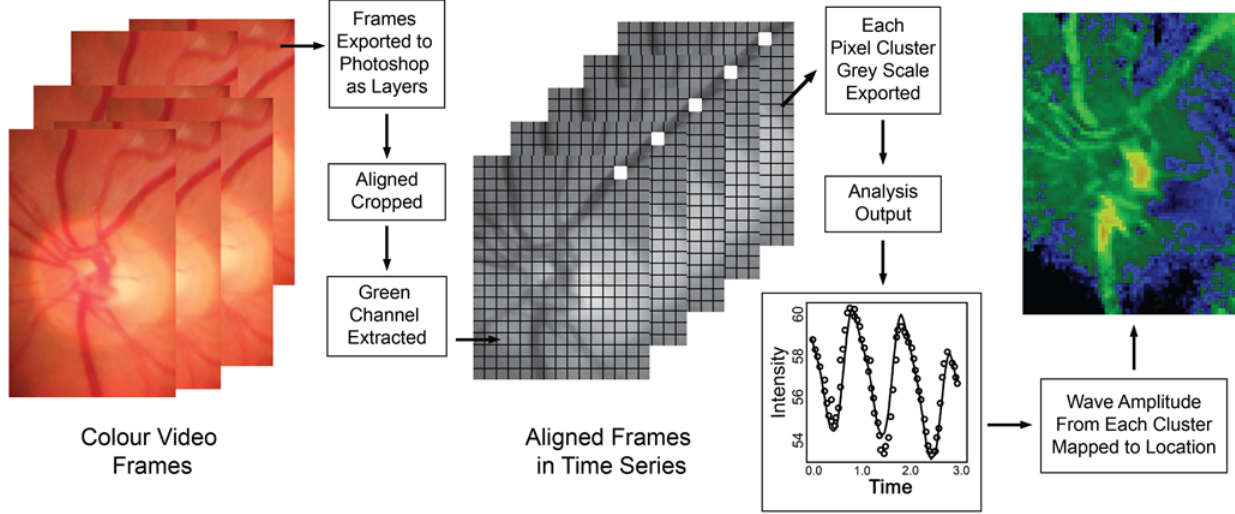
Figure 1. Schematic diagram of the technical sequence for objectively analysing the video frames, calculating pulsation amplitudes and generating heat maps of